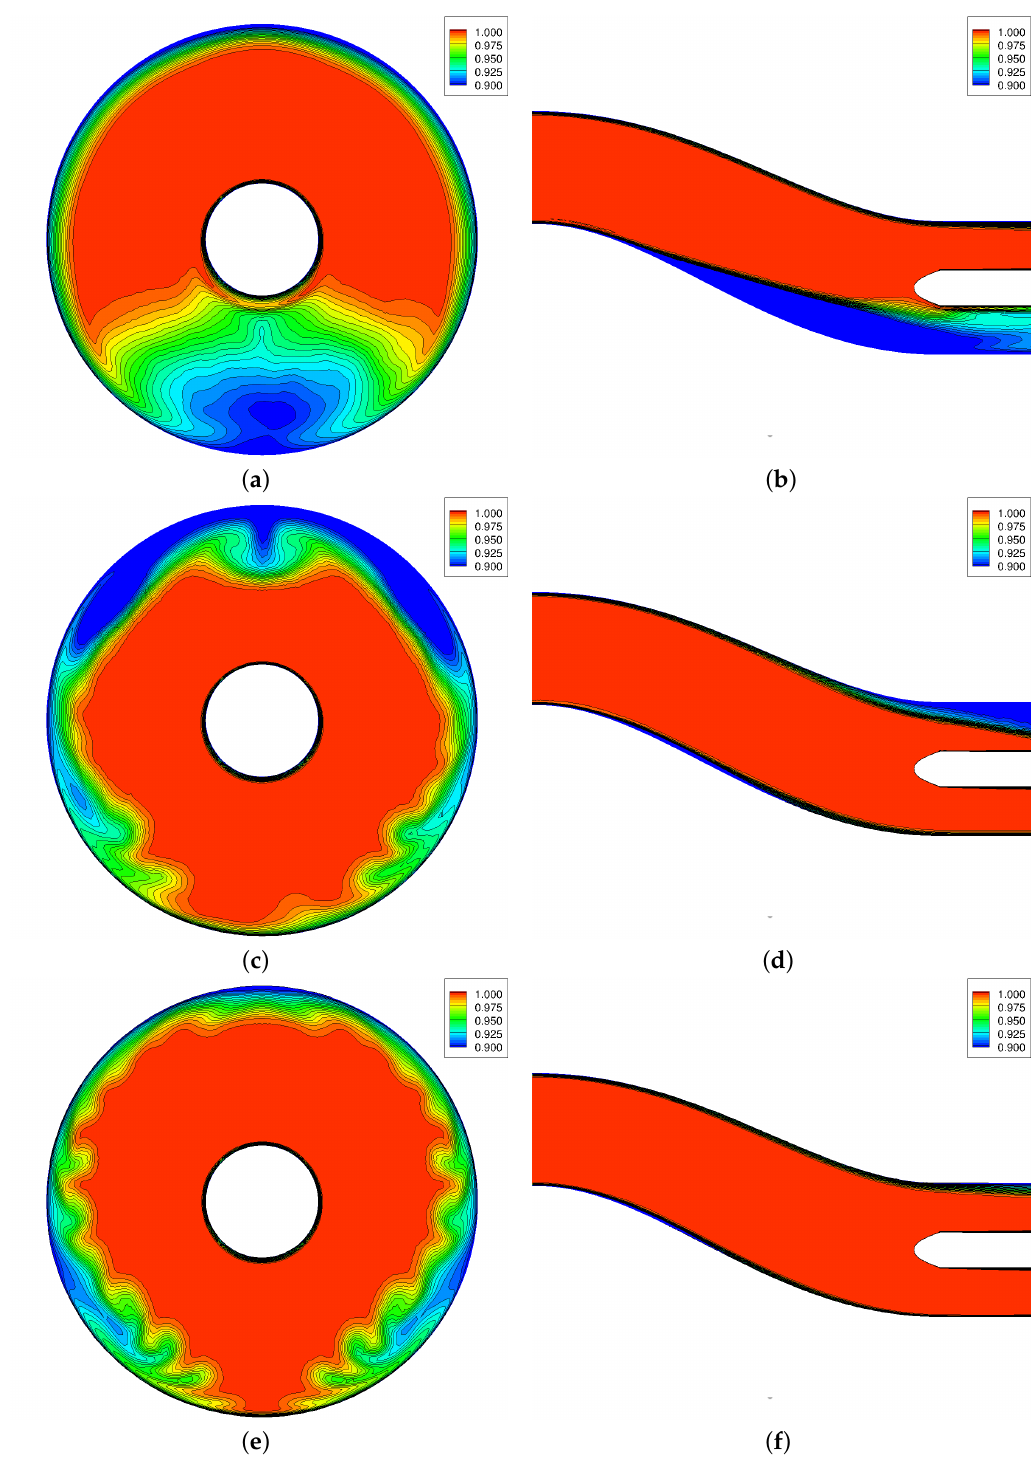
Figure 14. Engine face and symmetry pressure ratio using USAFA grids and SARC-DDES turbulence models. CFD data are time-averaged from 2 to 2.5 s of simulation time. ( a ) Baseline engine face; ( b ) Baseline symmetry; ( c ) Baseline + VG engine face; ( d ) Baseline + VG symmetry; ( e ) Baseline + Jets engine face; ( f ) Baseline + Jets